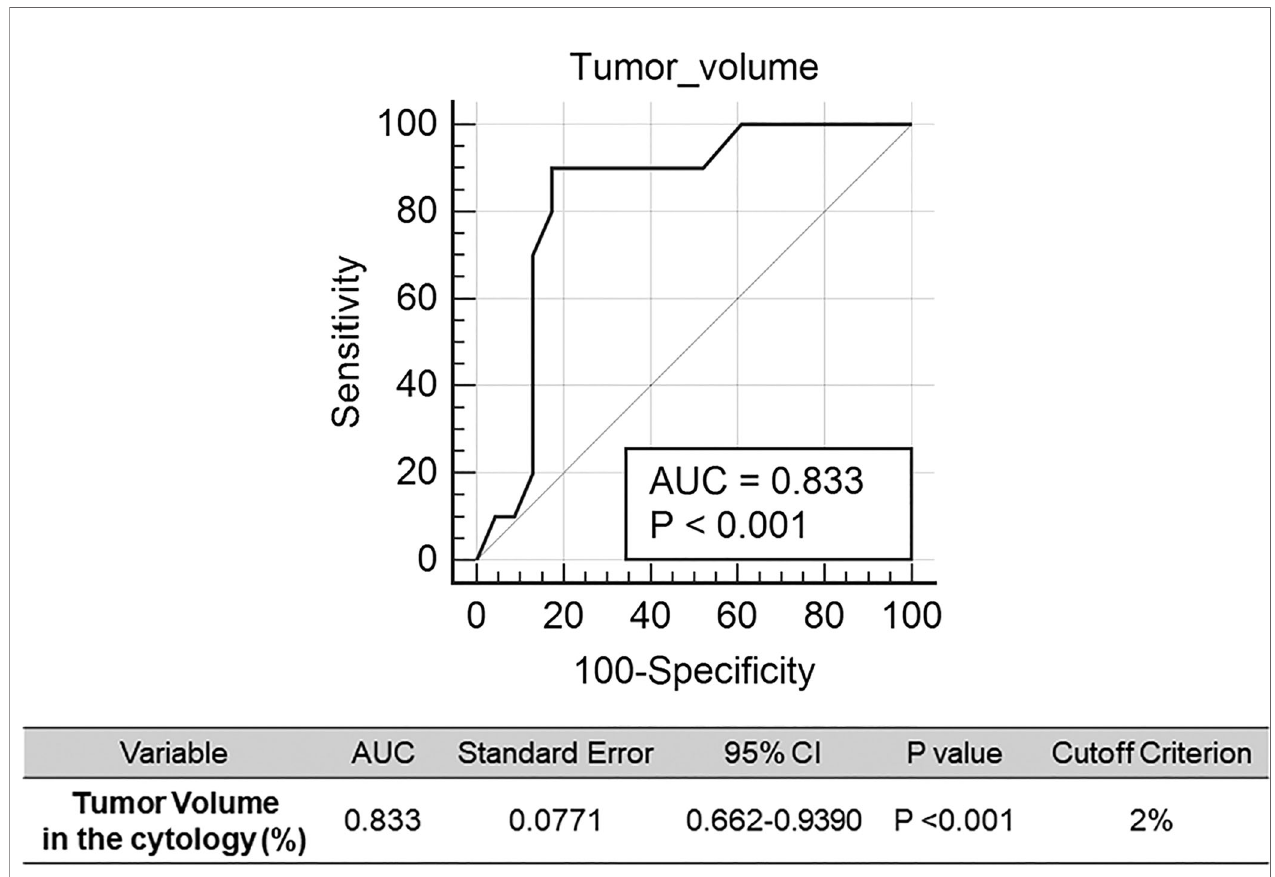
FIGURE 3 | Receiver operating characteristic (ROC) curves for detection of genomic mutation in the cytology sample. Cut-off of the tumor volume in the cytology was